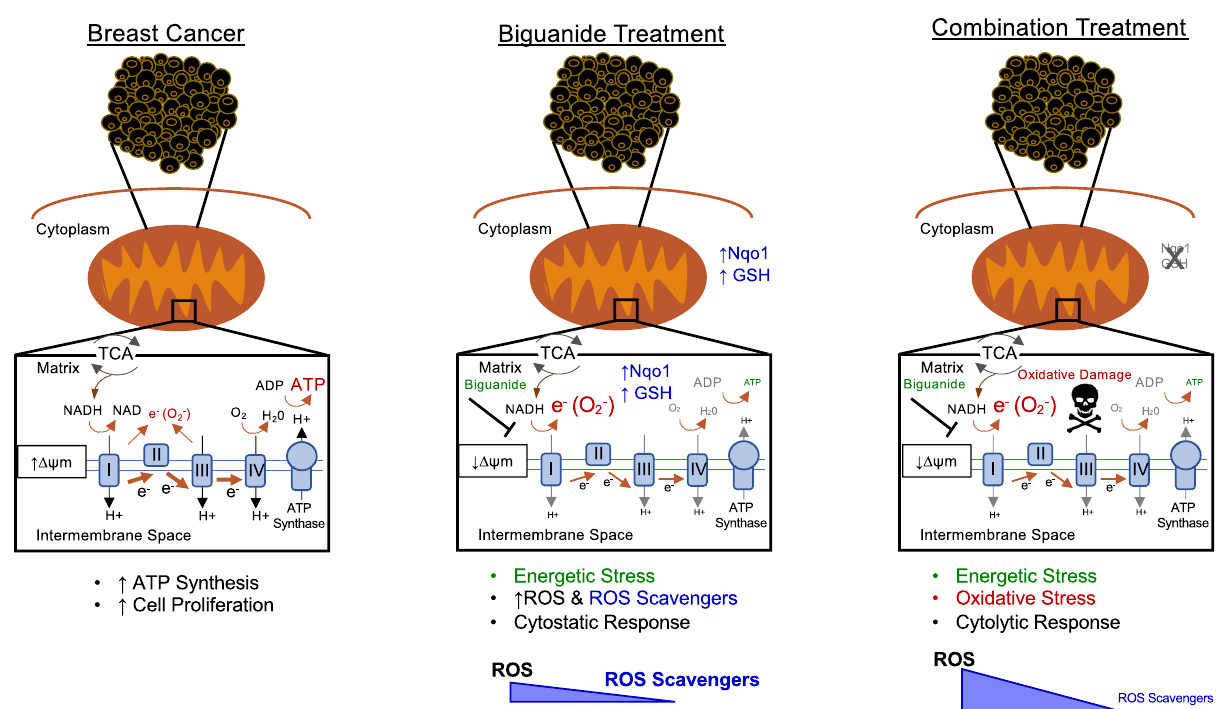
Fig. 9 Targetable ROS-scavenging mechanisms selectively sensitize human breast cancers to biguanide treatment. Most breast cancers are characterized by higher levels of oxidative phosphorylation and consequently increased mitochondrial membrane potential, in comparison to normal epithelial cells. Biguanides preferentially accumulate in cells with actively respiring mitochondria. Biguanide treatment as monotherapy inhibits complex I of the electron transport chain and OXPHOS leading to energetic stress. By inhibiting complex I, phenformin also increases mitochondrial superoxide generation. Combination therapy with phenformin and inhibiting tumor antioxidants, such as Nqo1 and glutathione, leads to oxidative stress in addition to energetic stress, and a potent tumoricidal